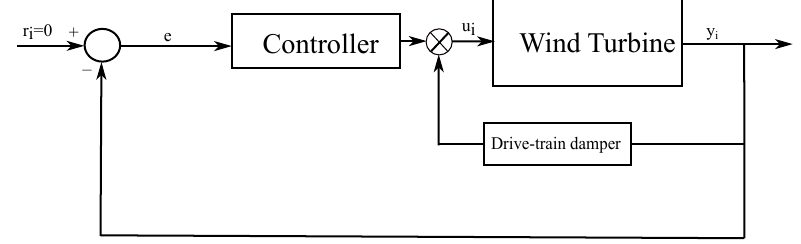
Figure 8. Control